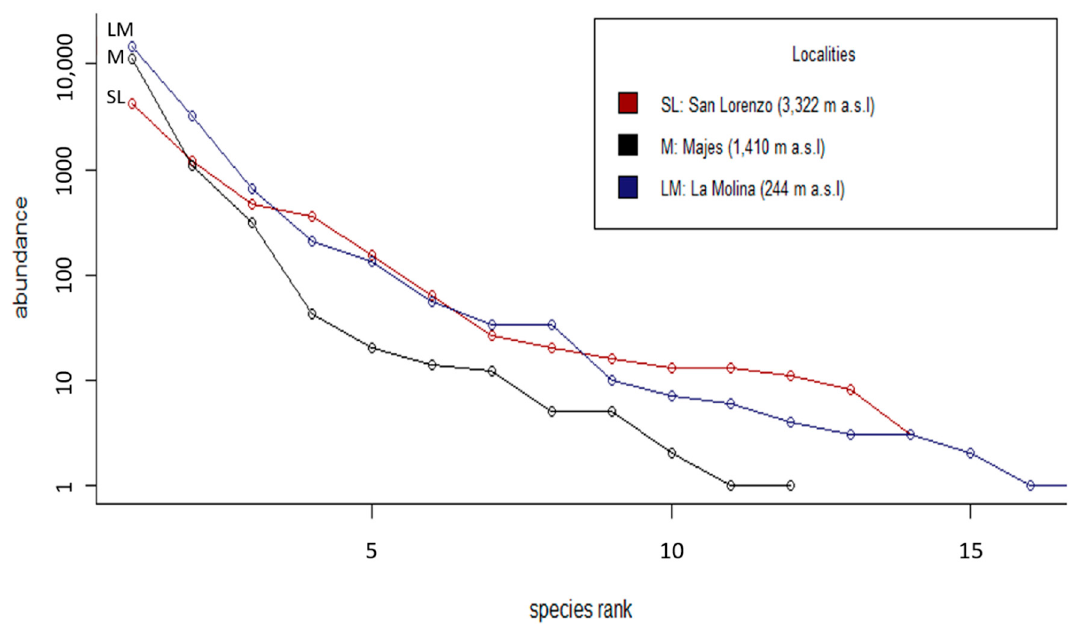
Figure 2. Rank–abundance curve of the phytophagous insects that infested the quinoa crop in San Lorenzo, Majes and La Molina (log series distribution).